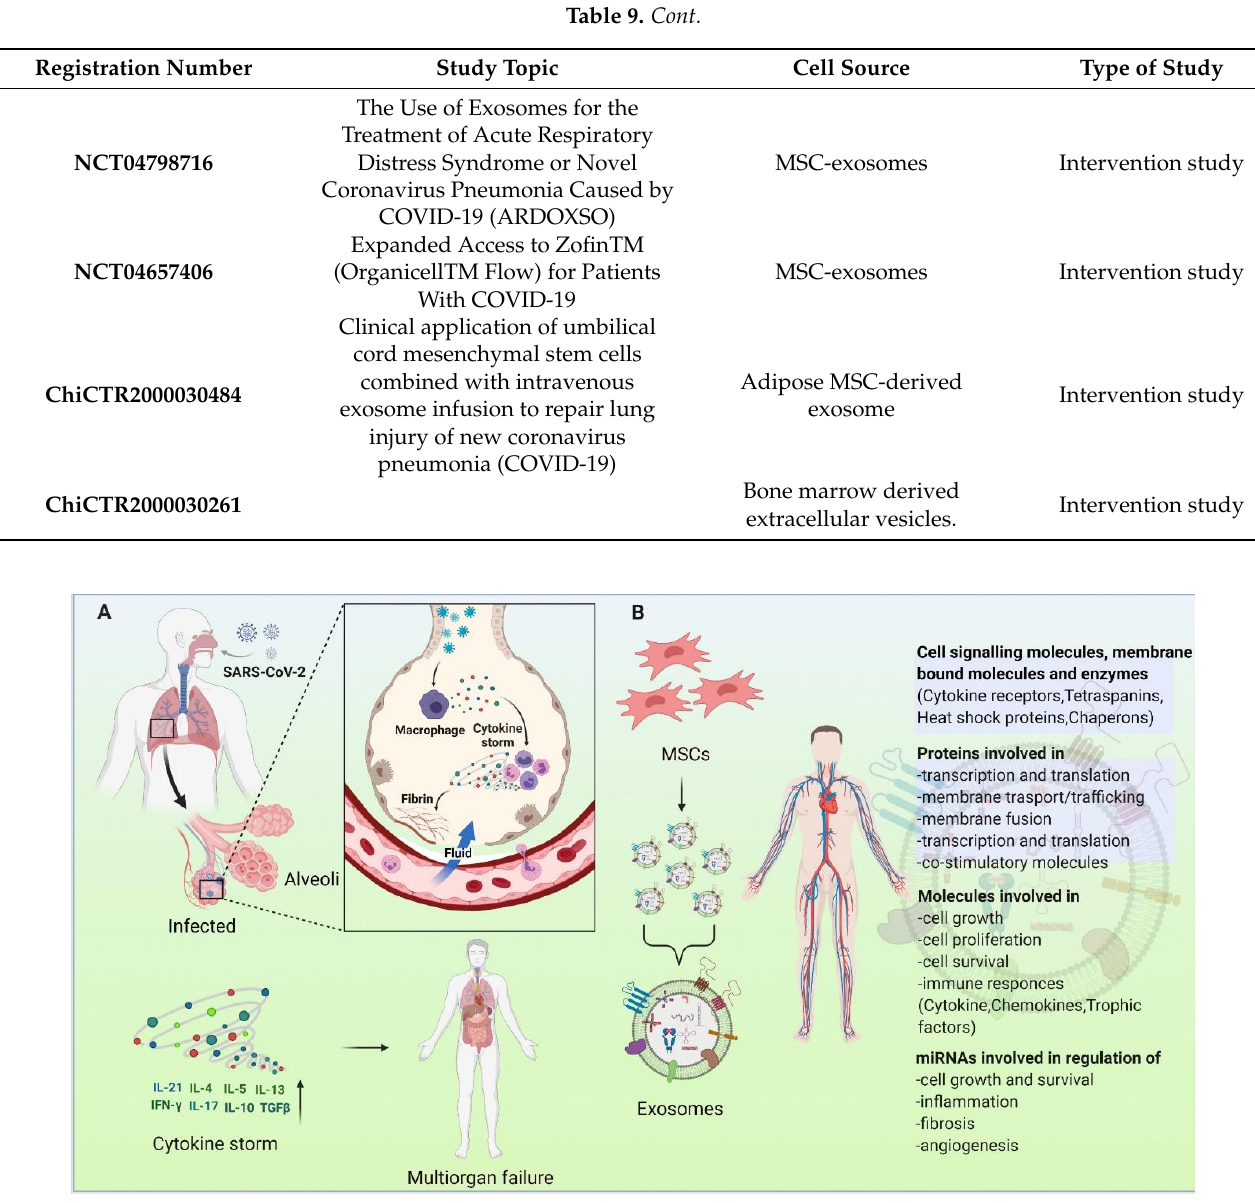
Figure 8. Schematic representation of role of cytokine storm in SARS-CoV-2 infection and possible therapeutic effects of MSCs and MSC-derived exosomes. ( A ) Pathogenesis of SARS-CoV-2; SARS-CoV-2 virus targets the lung epithelial cells. During this process, immune cells such as macrophages identify the virus particles and start to produce pro-inflammatory cytokines. These cytokines attract more immune cells, which in turn enhance the cytokine production. This creates a cycle of inflammation that damages the lung cells through the formation of fibrin. This damage results in weakened blood vessels, allowing fluid to seep in and fill the lung cavities, leading to respiratory failure and failure in multiple organs. MSCs and MSC-derived exosomes have the potent ability to suppress the inflammatory responses and prevent the progression towards multiple organ failure. ( B ) Putative mechanisms of MSC and MSC-derived exosome therapy in severe SARS-CoV2 cases; MSCs and MSC-derived exosomes have the potent ability to suppress the inflammatory responses and prevent the progression towards multiple organ failure. Isolated MSCs cultured in conditioned media that induces the release of exosomes. The MSCs identify the extracellular signals and start the packaging of several regulatory factors into exosomes that are released into the conditioned medium. These exosomes contain different growth factors, metabolic enzymes, molecules involved in immunomodulation, cytokine receptors, molecules important for cell division and proliferation, DNA, and regulatory miRNAs. In MSC-derived exosome therapy, exosomes are administered intravenously or via aerosol inhalation. The administered exosomes inhibit inflammatory cytokines and other immune regulatory cells which results in the suppression of the cytokine